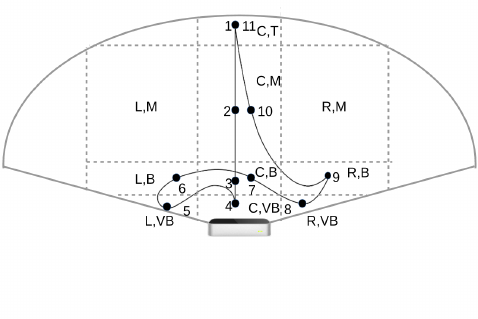
Fig. 8: Sequential positions of the user’s hand, tracked by the Leap Motion : (1-C, T), (2-C, M), (3-C, B), (4-C, VB), (5- L, VB), (6-L, B), (7-C, B), (8-R, VB), (9-R, B), (10-C, M), (11-C, T).